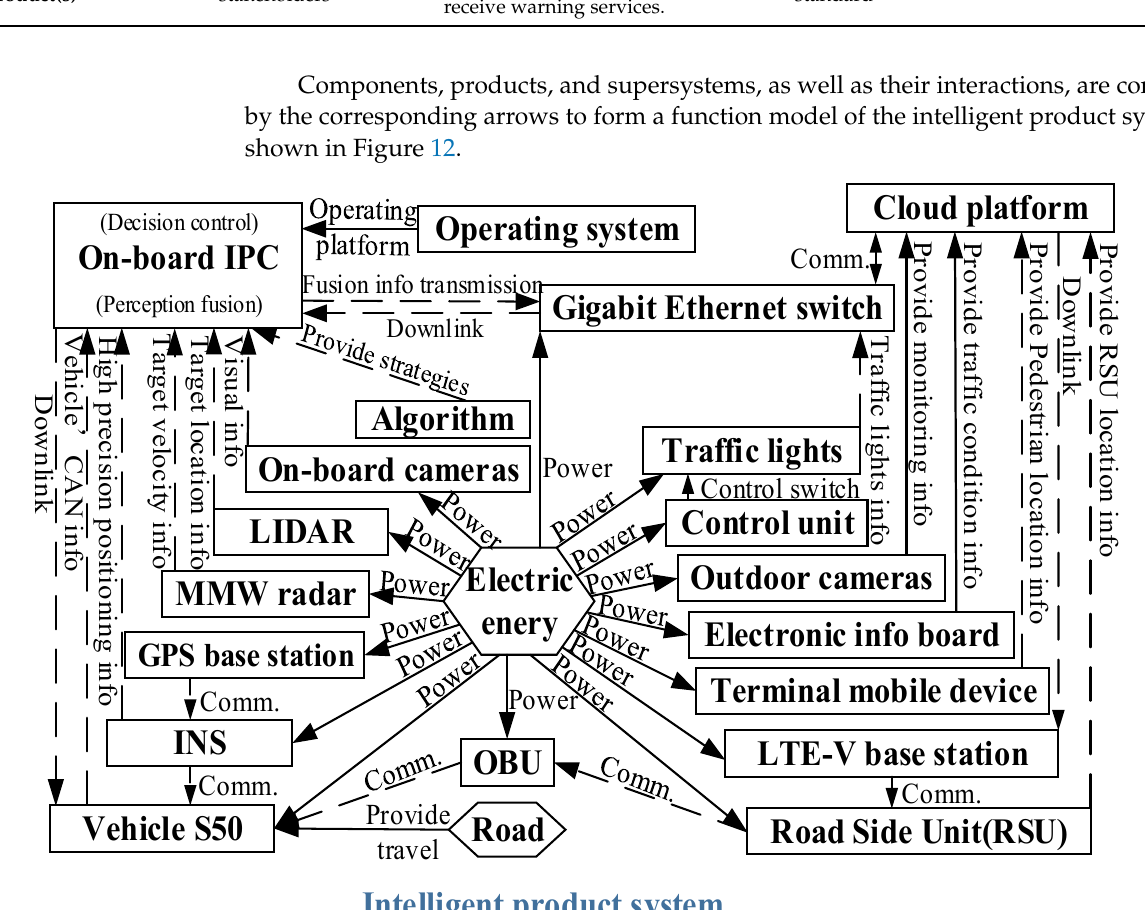
Figure 12. Function model of the intelligent product system. (b) Function modeling of stakeholders